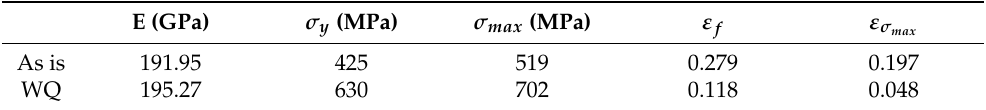
Table 2. Experimentally measured stress and strain properties for the as-is and WQ material under quasi-static testing